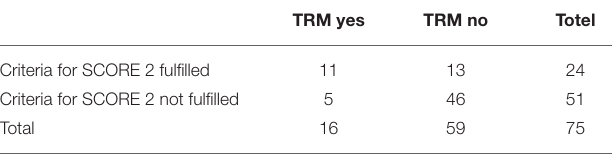
TABLE 6 | Accuracy of the prediction of TRM by identification of score 2 patients (criteria “TIM3 over 950ng/ml and sIL-2rec over 8,100 ng/ml” assayed at Day +